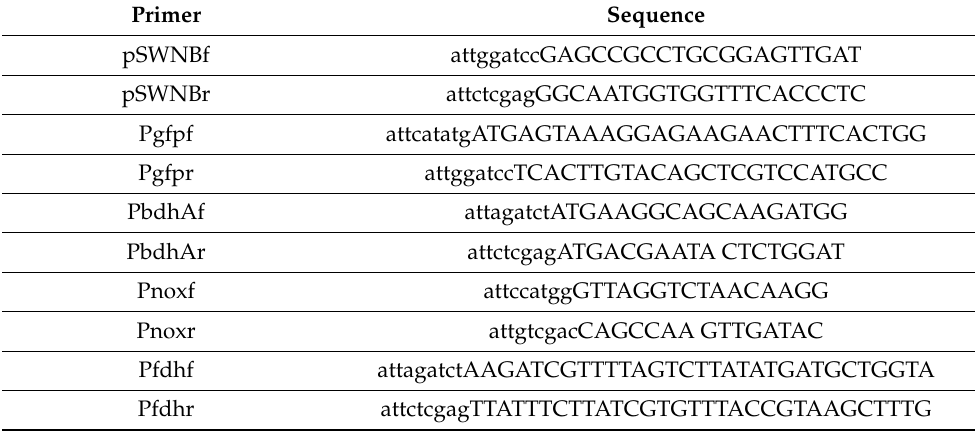
Table 6. Primers used in this